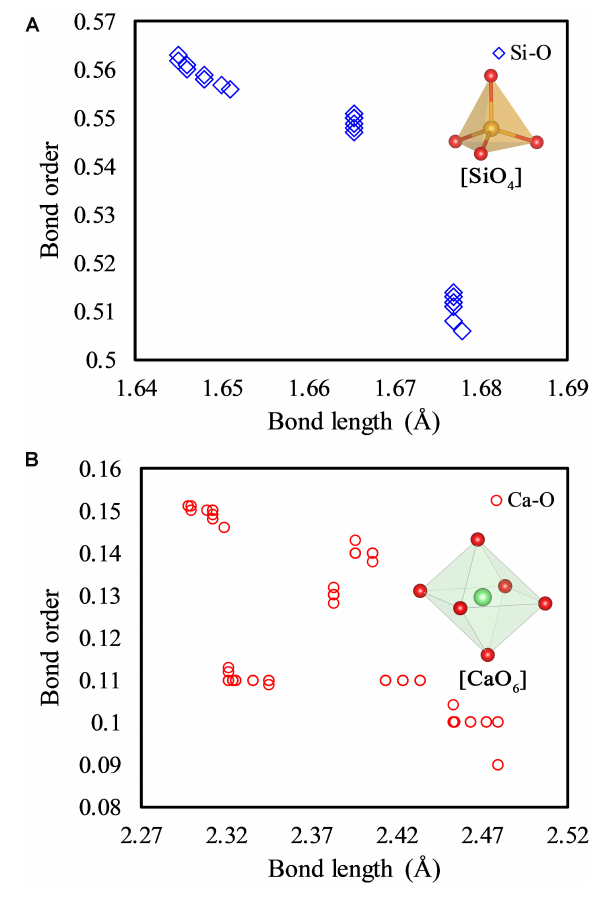
FIGURE 3 | Bond order-bond length distribution of Si-O bonds (A) and Ca-O bonds (B) of the pure γ -Ca 2 SiO 4 crystal. The coordination structures of the Si atom and Ca ion are illustrated in plots (A) and (B)